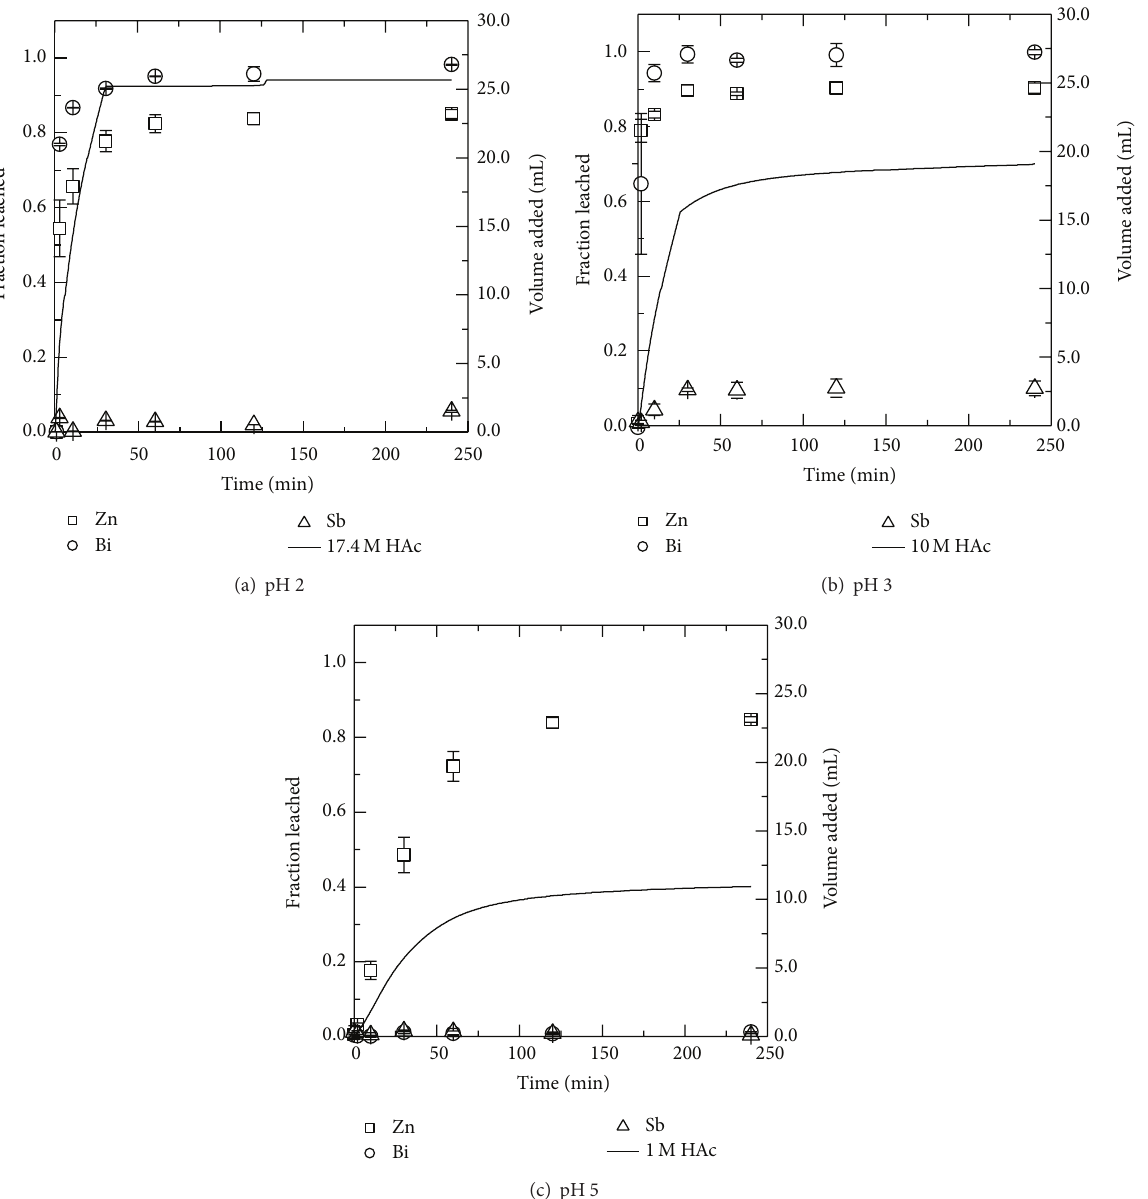
The speciation of zinc in hydrochloric acid solutions as calculated by PHREEQC indicates that Zn 2+ is the most dominant species in the hydrochloric acid based leachates obtained here. In the pH 5 hydrochloric solution, Zn 2+ accounted for approximately 92% of all zinc species but as the pH of the acidic leachate decreased to pH 1 the free Zn 2+ con- centration in solution decreased due to the formation of zinc- chloride complexes. Other zinc-chloride species predicted to + (11%), be present in pH 1 chloride solutions include ZnCl 3− 4−2 (0.3%), and ZnCl ( 1.5 ZnCl 2 (2%), ZnCl